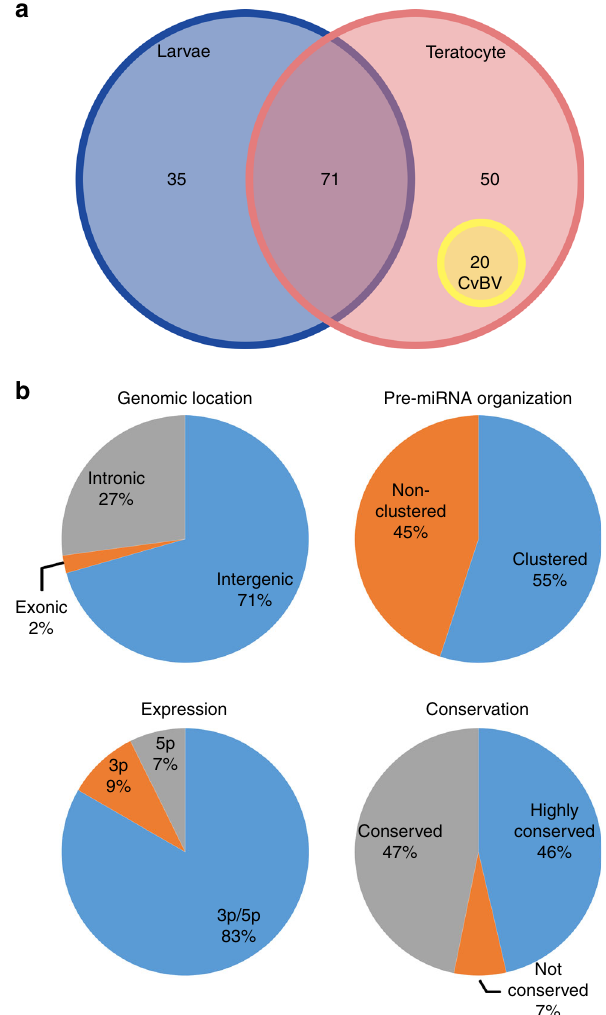
Fig. 1 Characteristic of miRNAs in C. vestalis . a miRNAs in C. vestalis larvae and teratocytes. The yellow circle indicates 20 miRNA precursors expressed in teratocytes and encoded within the CvBV proviral genome.